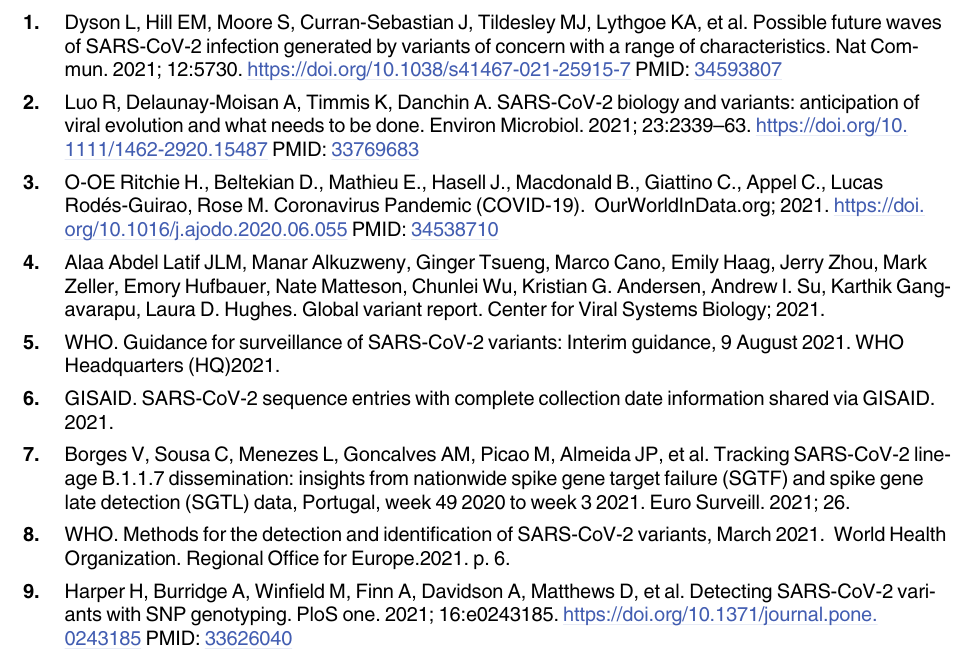
S3 Table. Sub-consensus SNV and Indel frequency data of ONT and Illumina. (XLSX) S1 Methods. Methods in detail used in the